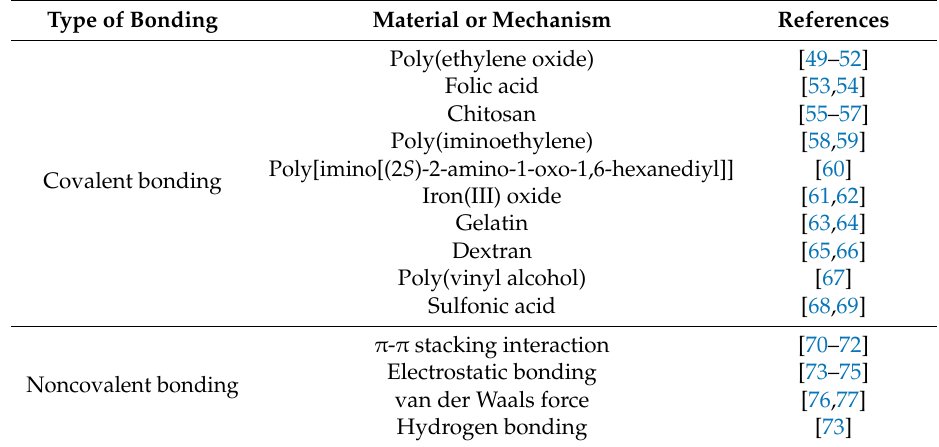
Figure 3. Schematic representation of common modifications of graphene oxide. Table 2. Summary of frequently prepared covalently and noncovalently modified GO for drug delivery purposes.